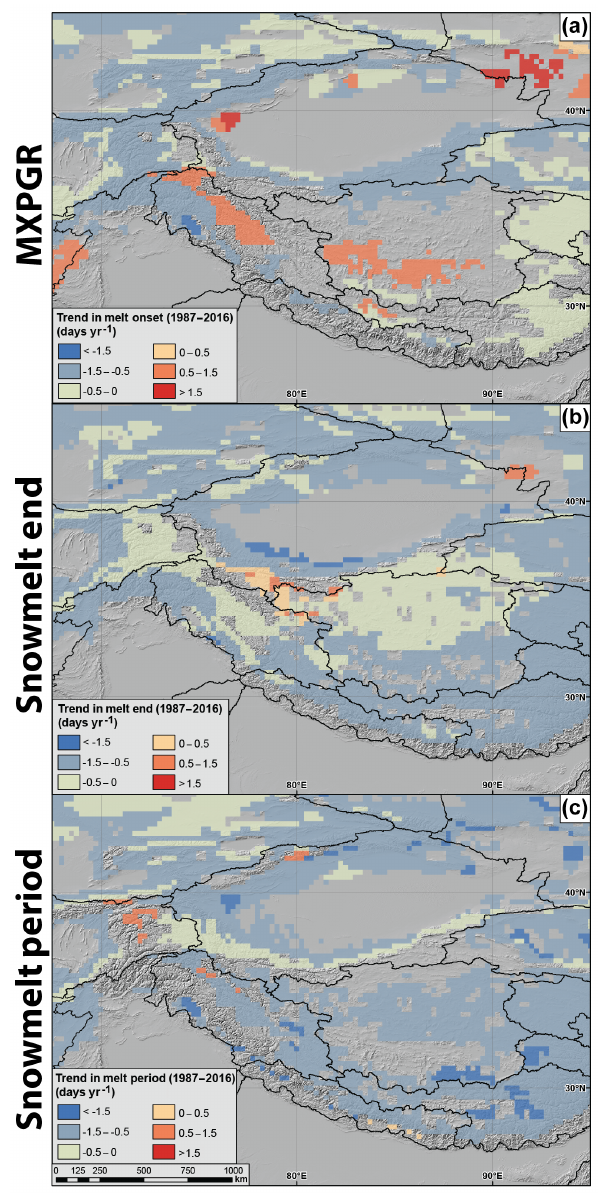
Figure 9. Significant ( p < 0 . 05) trends in date of (a) MXPGR, (b) snowmelt end, and (c) snowmelt period, 1987–2016 for the cluster areas (see Fig. 8). The MXPGR is generally moving earlier outside of the Tibetan Plateau–Karakoram region and moving slightly later in a high-elevation zone running from the Karakoram through the Tibetan Plateau interior, as well as parts of the Himalaya. The end of the melt season is moving earlier in the vast majority of HMA, at varying rates. Consequently, the snowmelt period is also shrinking in much of HMA, with the exception of small parts of the Pamir, Karakoram, and Tian